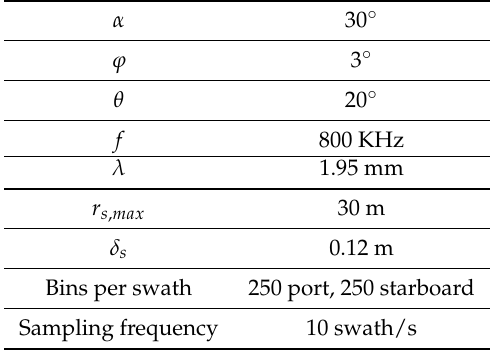
Table 1. Parameters of the Imagenex SportScan SSS used in this